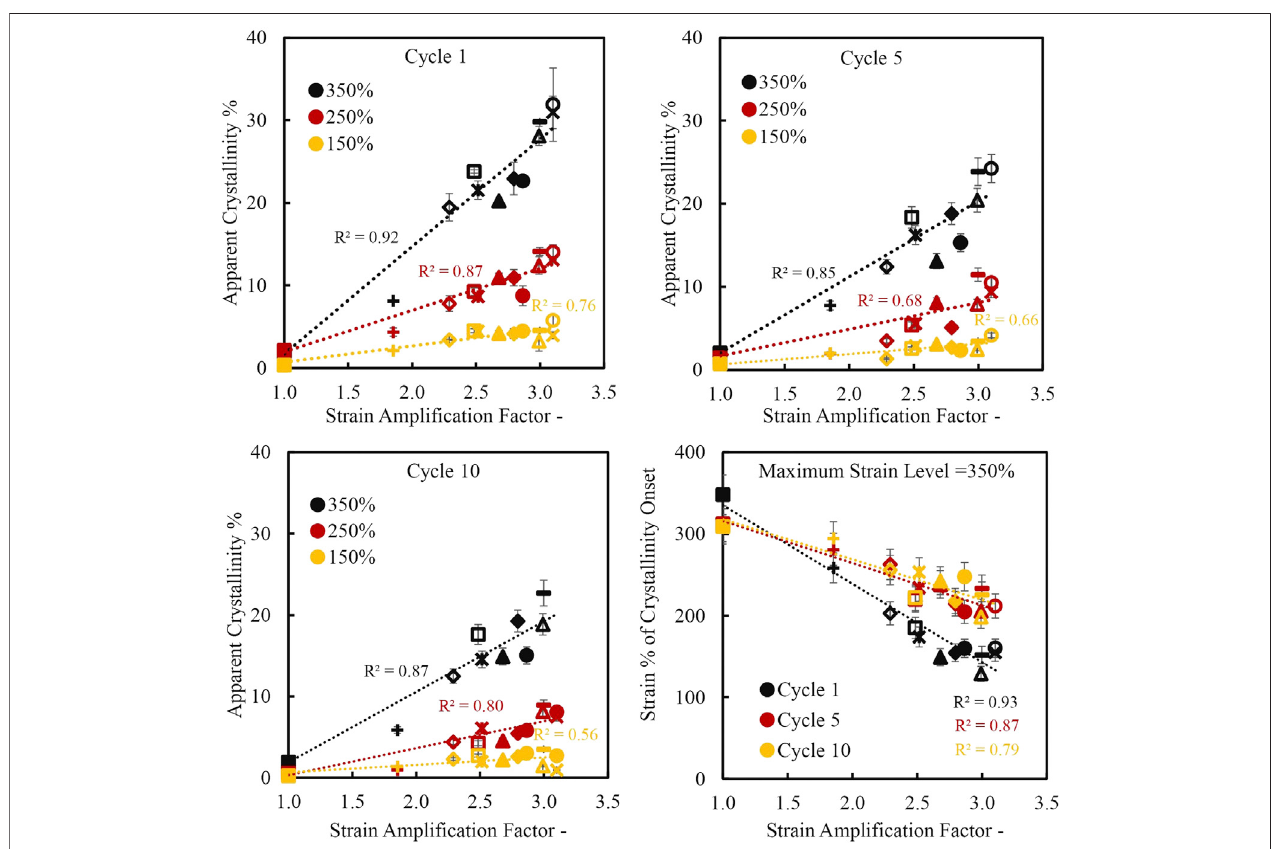
FIGURE 11 | Apparent crystallinity percent and onset of crystallinity as a function of strain ampli fi cation factor of carbon black reinforced and unreinforced natural rubber extended on cycles 1, 5 and 10.